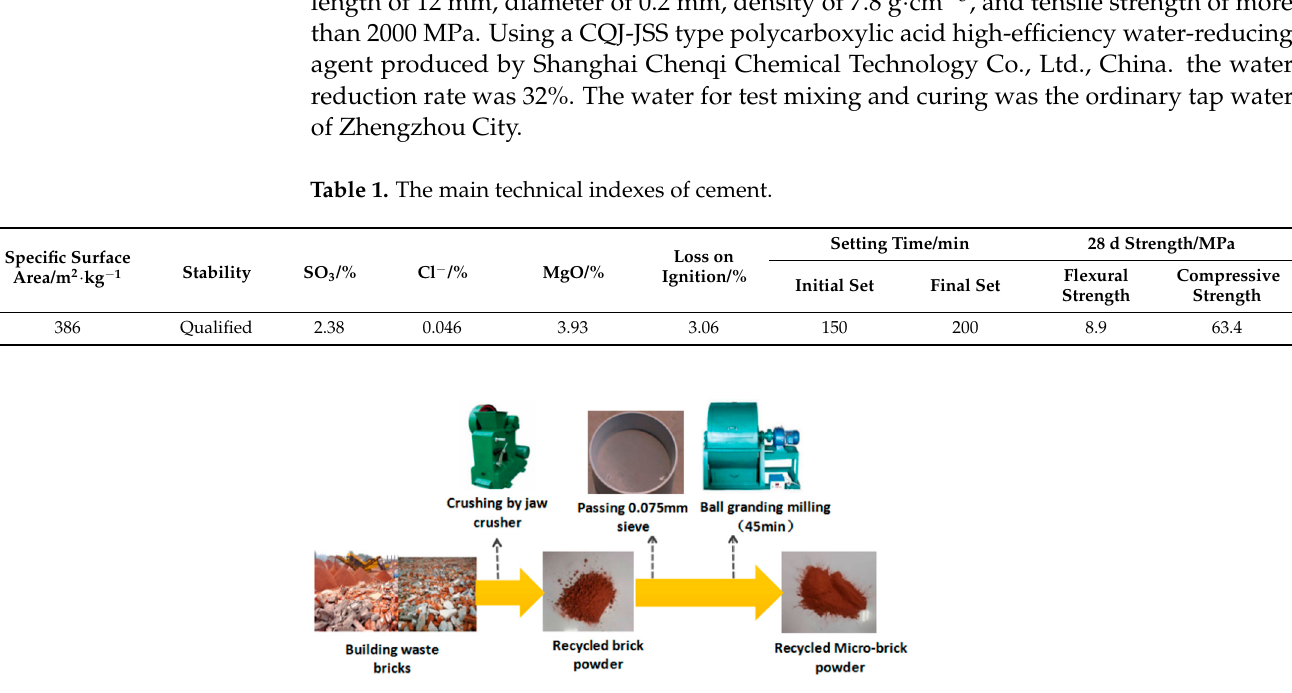
Figure 1. A flow chart of recycled brick powder preparation. Table 2. The main material property indicators and components of recycled brick Table 1. The main technical indexes of cement.